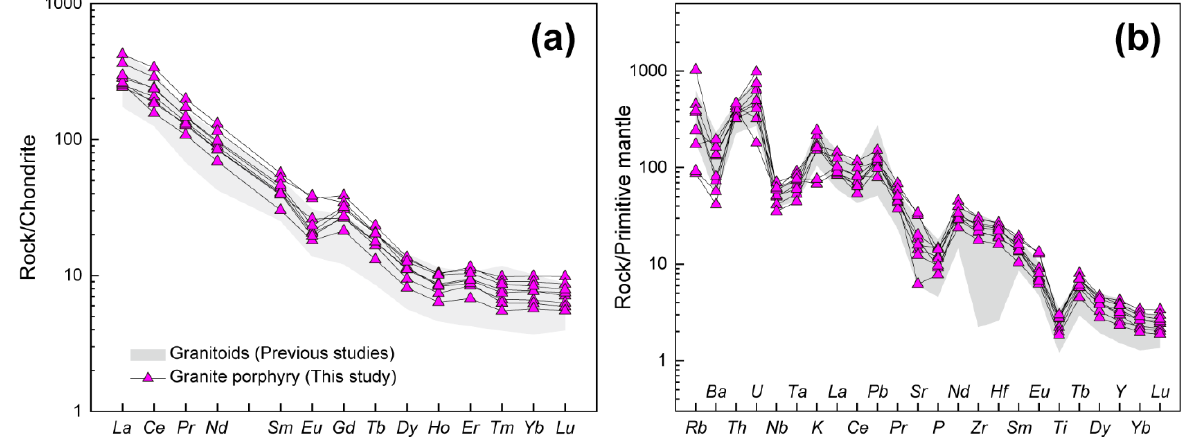
Figure 6. ( a ) Chondrite-normalized REE diagram and ( b ) primitive mantle-normalized trace element patterns diagram [40] for the Hongniu-Hongshan granitoids. Literature data is the same as that in Figure 5.